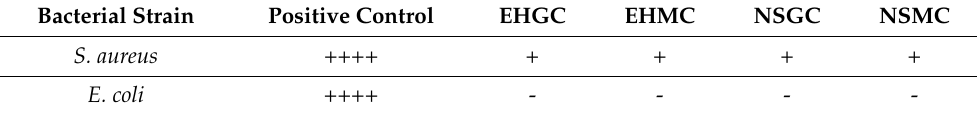
Table 8. Antibacterial activity of cone extracts (1 mg/mL in 1% DMSO) by disc diffusion test. Bacterial Strain Positive Control EHGC